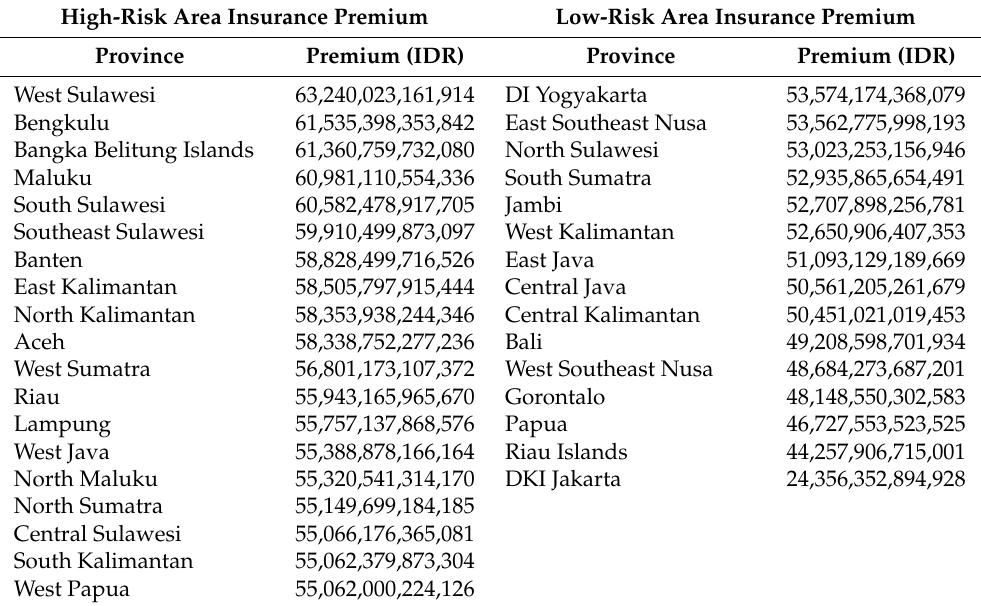
Table 3. Disaster insurance premiums in each province in